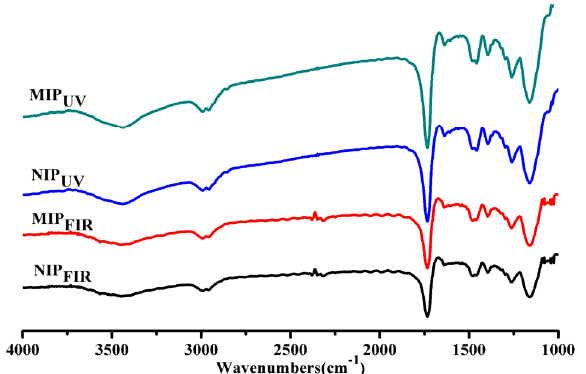
Figure 2. Comparative IR spectra of prepared materials by FIR- and UV-polymerization